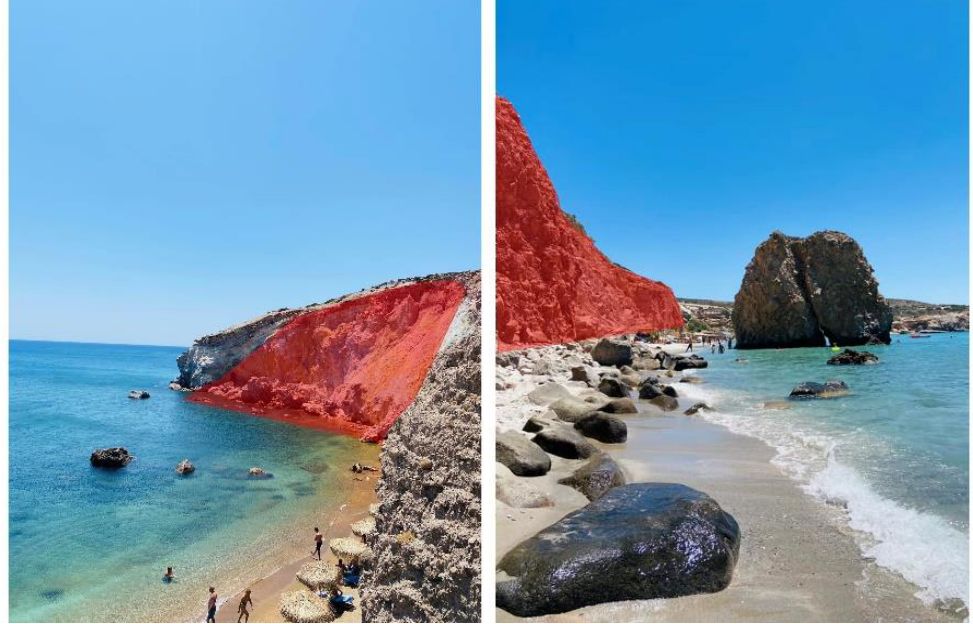
Figure 8. Images representing two coastal areas on eastern Milos nearby to active or potential landslide triggering. (Firiplaka on the left and Palaiochori on the right ). Table 6. Percentages of susceptibility classes to landslides in Milos and Thira islands. Very Low Low Medium High Very High